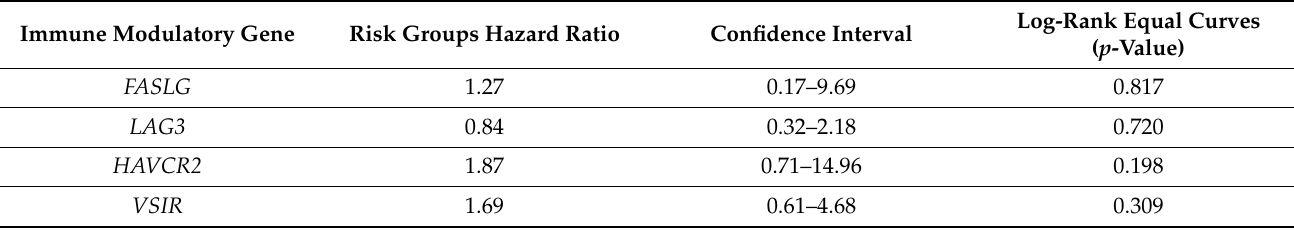
Figure 2. Association between immune modulators and survival in CCA patients. The Kaplan–Meier survival curves in SurvExpress CCA patients for the gene expression of ( A ) CD274 (PD-L1) , ( B ) PDCD1 ( PD-1) , ( C ) CTLA4 and ( D ) IDO1 . Low-risk groups are indicated in green and high-risk groups are indicated in red. The x-axis presents the study time in months. HR, CI and p -values are shown in the insert. Table 4. SurvExpress-based overall survival of 35 CCA patients.